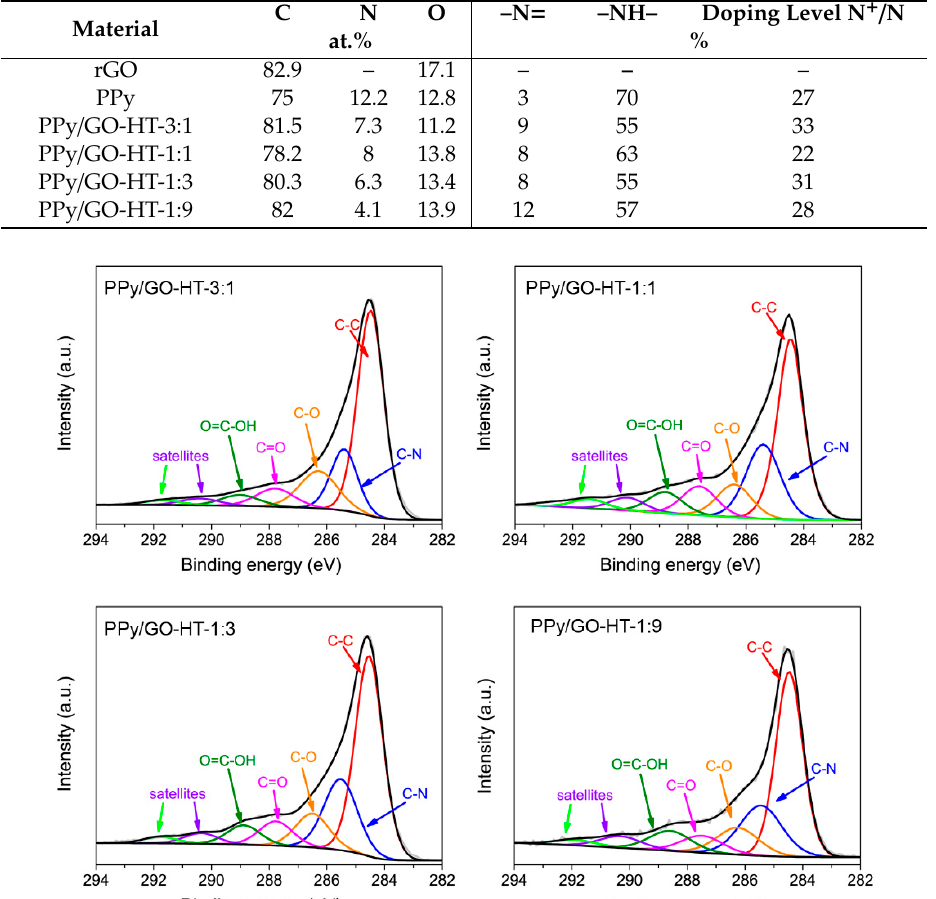
Table 2. Chemical composition of the rGO, PPy and PPy/GO-HT hybrids as determined by XPS.